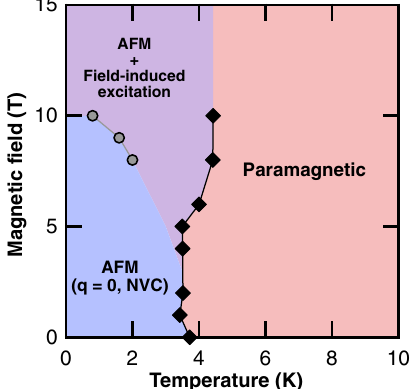
FIG. 9. B - T phase diagram of Cd-K. The boundary of the AFM phase is determined by the peak temperature of C=T (black diamonds) shown in Fig. 8. The threshold fields where the onset of the finite Δ T asym y is observed in the field dependence [Fig. 4(c)] are shown by gray